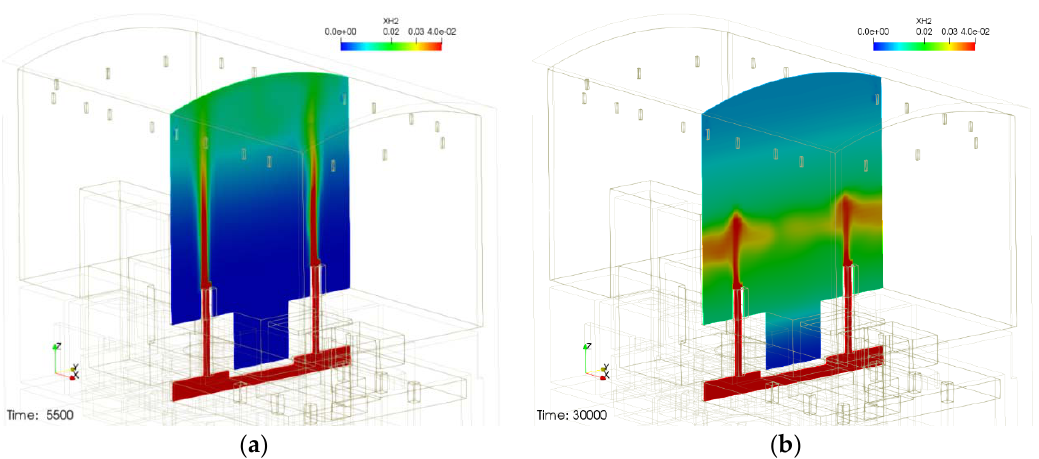
Figure 2. Hydrogen stratification induced by PARs installed in a small modular reactor containment, ( a ) before hydrogen stratification and ( b ) hydrogen stratification occurred.